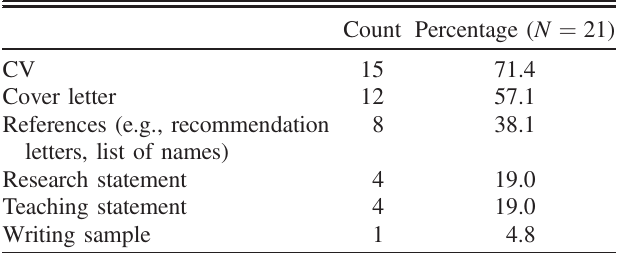
TABLE III. Application materials required for PER postdoc